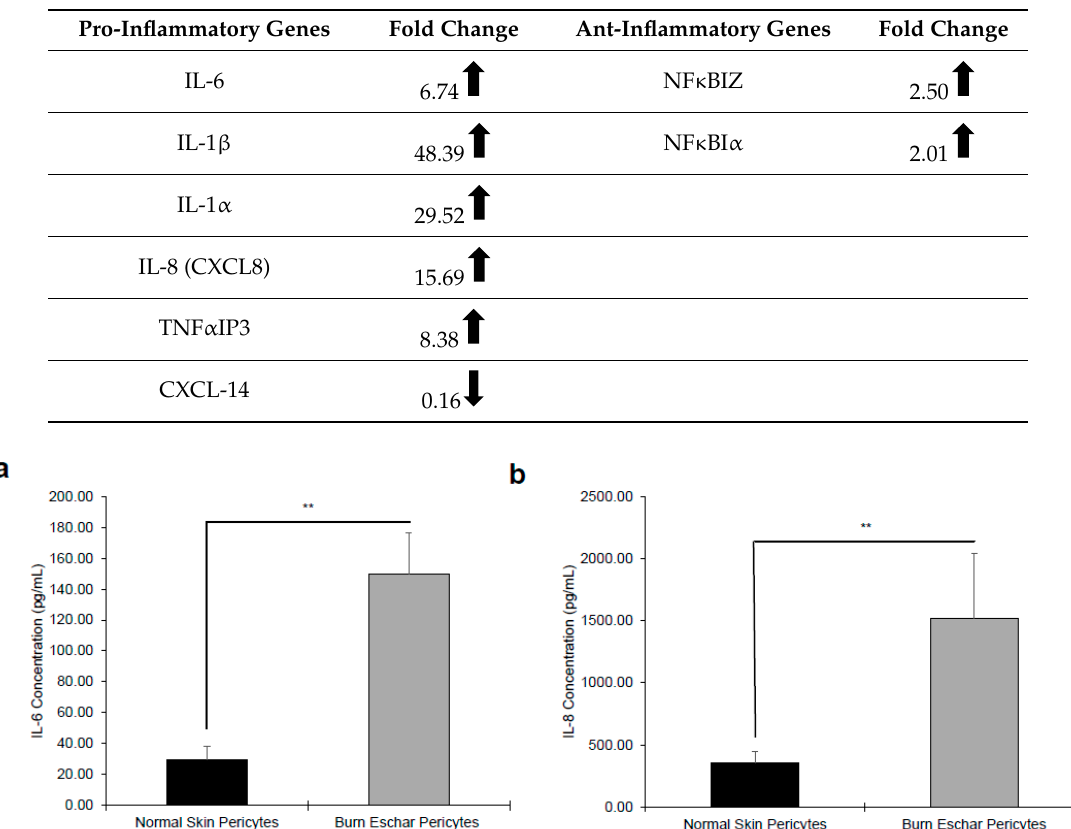
Table 2. Expression profile of pro- and anti-inflammatory genes in burn eschar pericytes from RNA-seq analysis.